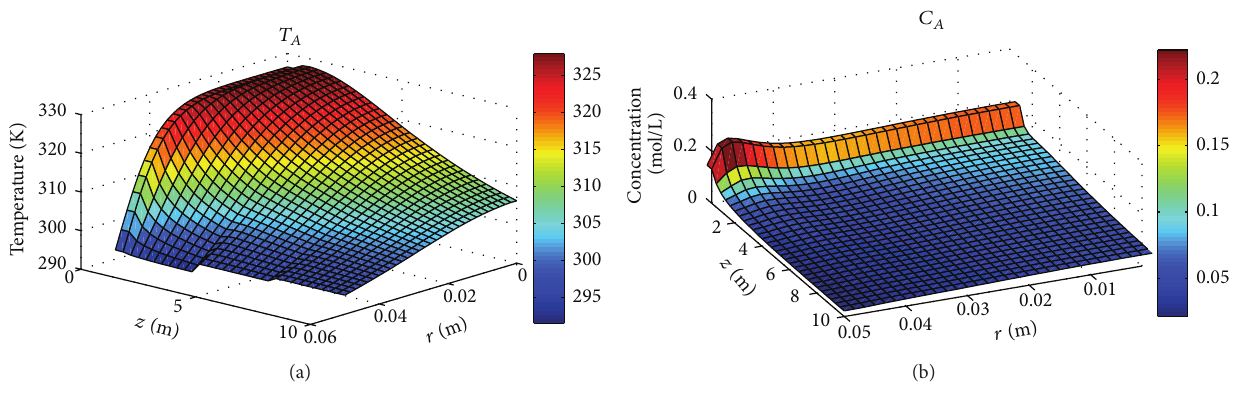
Figure 4: Steady state concentration and temperature